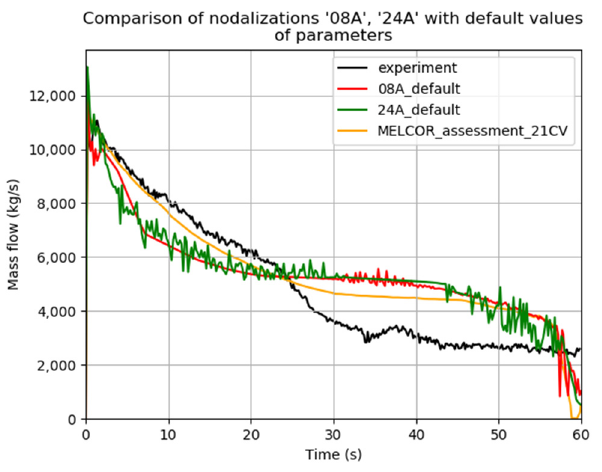
Figure 6. Mass flow rate for the 3 × 3, 24A nodalizations compared with the experimental data.